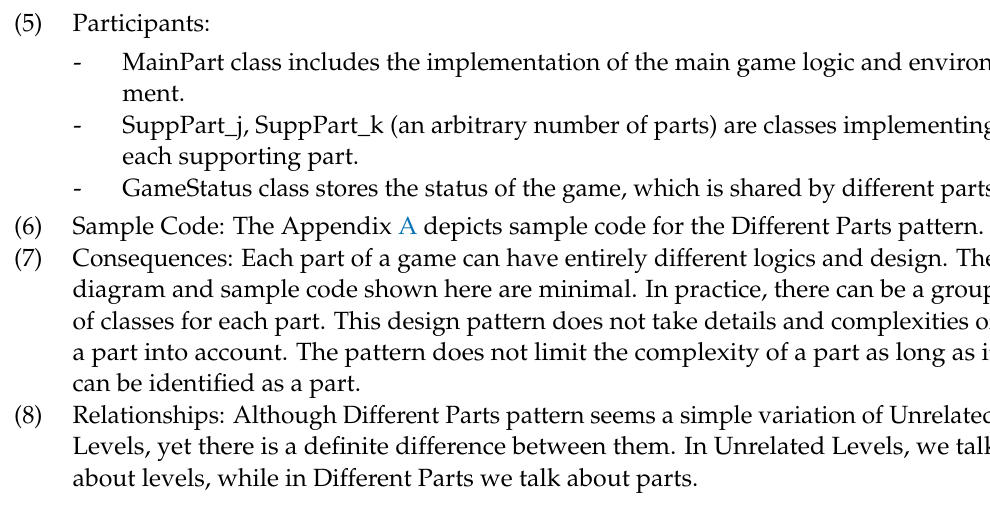
Figure 16. Class diagram of Different Parts